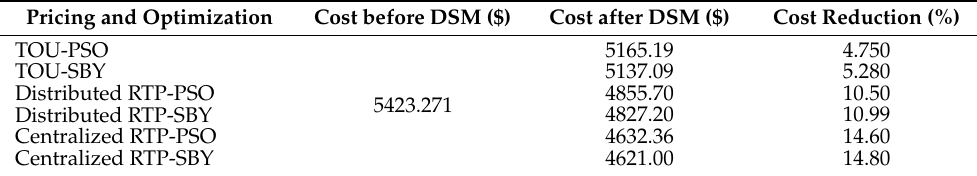
Table 6. Comparison of DSM with the TOU and RTP pricing for the industrial area. Pricing and Optimization